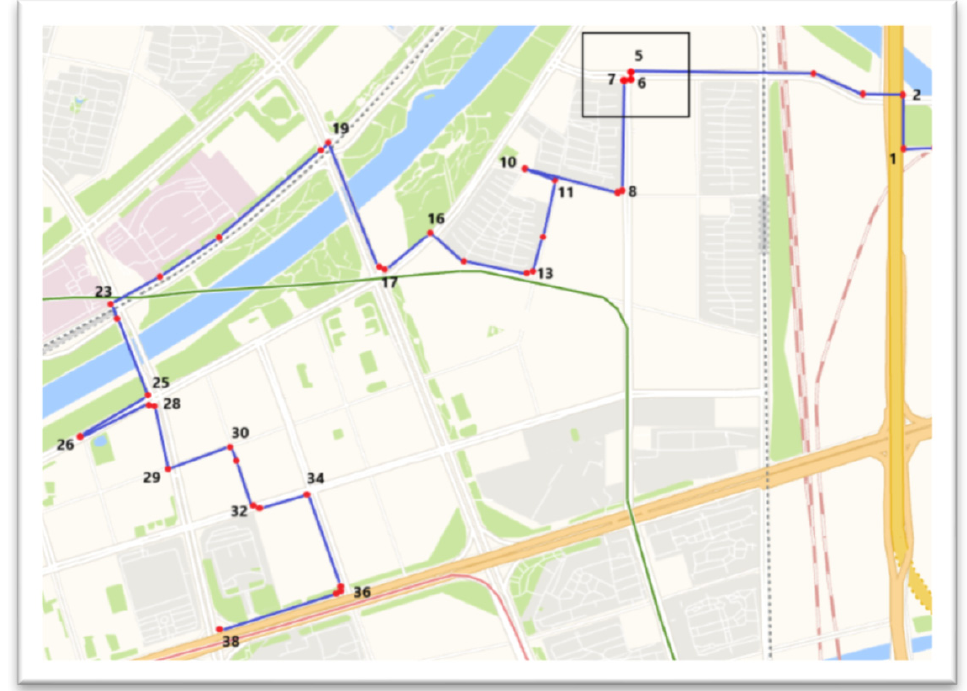
Figure 14. Overlay of trajectory data and actual road network. Table 6. Turning modes recognized by this algorithm.